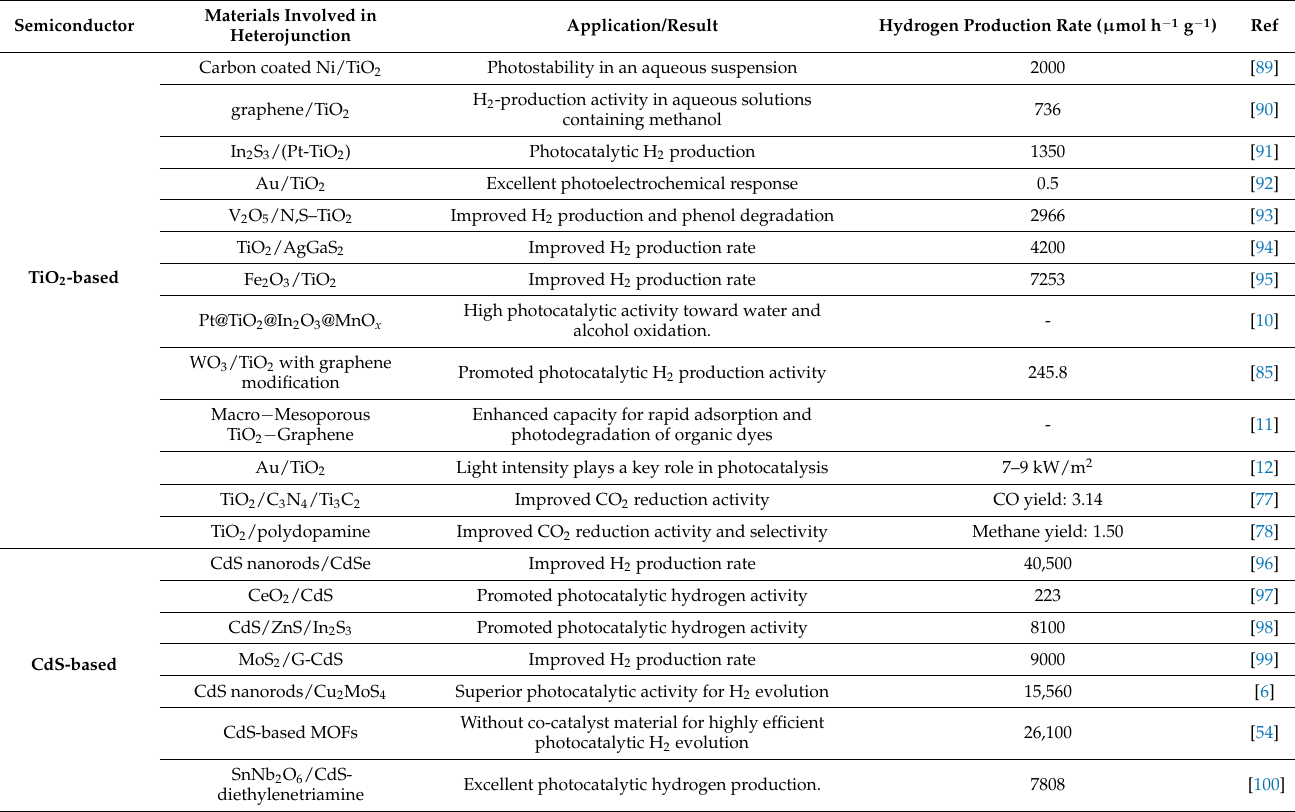
Table 1. Some investigations into heterojunction semiconductors with their hydrogen production